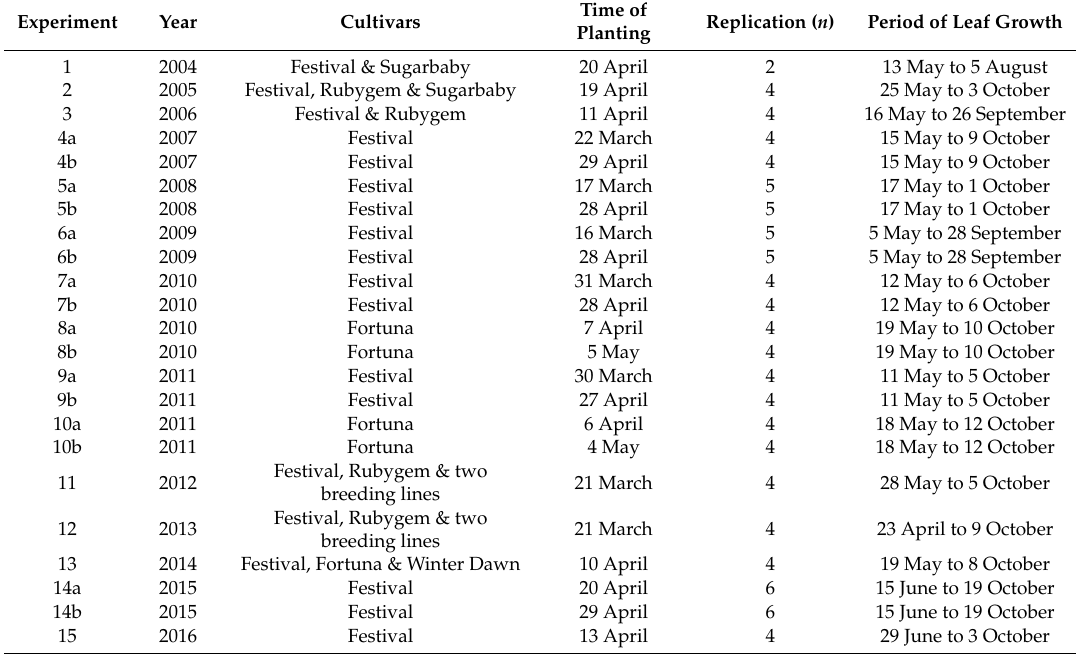
Table 1. Details of the experiments conducted to investigate productivity and leaf growth in strawberries in